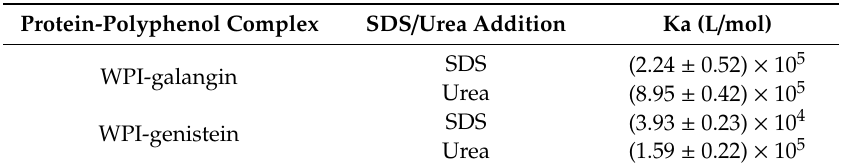
Table 3. E ff ects of sodium dodecyl sulfate (SDS) and urea on the apparent binding constants (Ka) for the non-covalent WPI-galangin / genistein interactions at 293